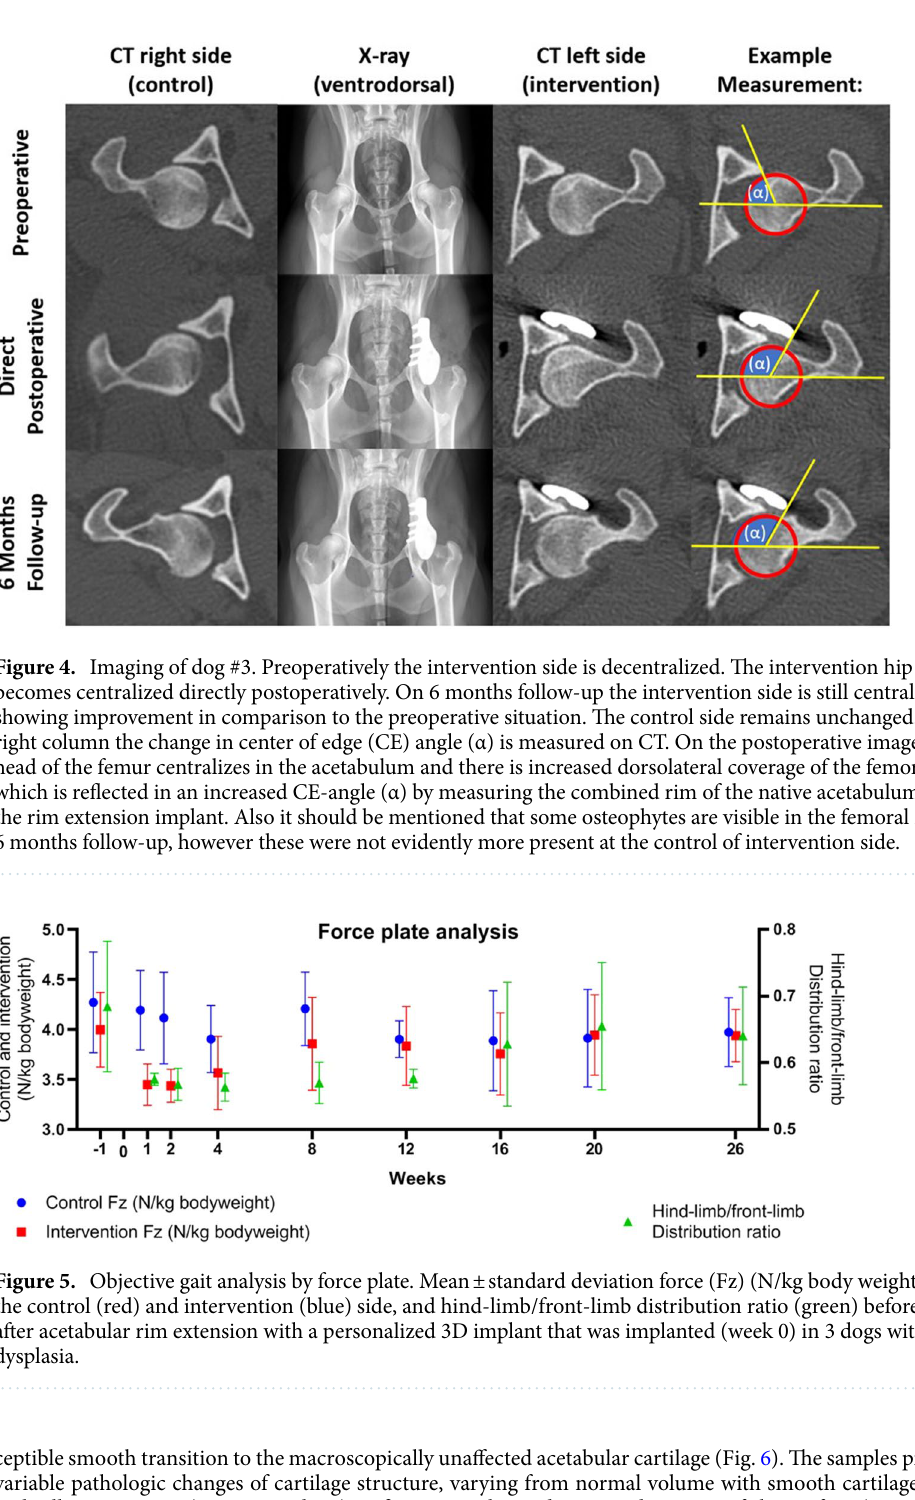
ceptible smooth transition to the macroscopically unaffected acetabular cartilage (Fig. 6). The samples presented variable pathologic changes of cartilage structure, varying from normal volume with smooth cartilage surface with all zones intact (OARSI grade A) to fissures to the mid zone and erosion of the surface (OARSI grade C). No additional histological damage to the acetabular or femoral cartilage, or metallosis due to the implant was observed in the intervention hips compared to the control hips (Fig. 7). Likewise, the synovial membrane presented with variable levels of absent (control hip dog#1 and all intervention hips) to mild synovitis (control hips of dog#2 and dog#3) evidenced by an increase in the number of cell layers (up to 3) and finger-like villous hyperplasia. Full histological results are presented in the Appendix 6.